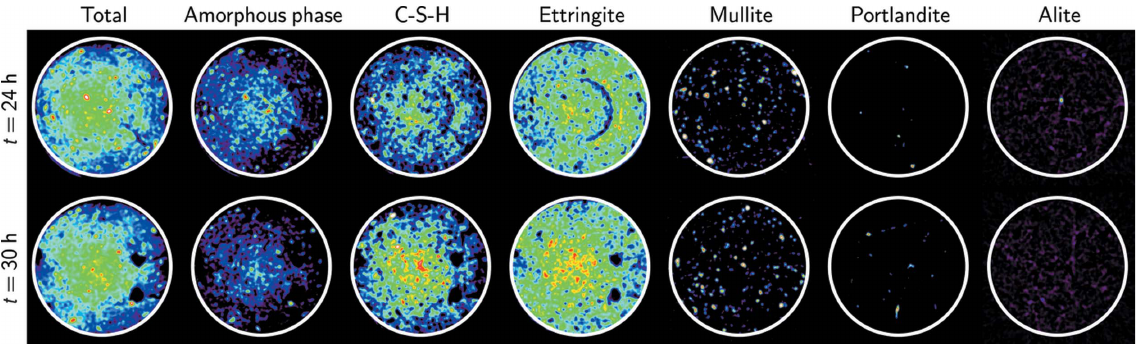
Figure 6 Distribution of the phases after (top row) 24 h and (bottom row) 30 h of cement hydration. From left to right, the distribution maps integrate the contribution of all the identified phases and the amorphous, C-S-H, ettringite, mullite, portlandite and alite phases. Red values indicate a higher content of the phase in the distribution map. Black values indicate voids (Total map) and voids or absence of phase (all other maps). Because all the maps were constructed from the number of counts integrated according to the procedure described in the Materials and methods section, they were scaled individually, and the sum of the colours of each map for the individual phases does not equal the colour of the total intensity map. The white circle of 1.3 mm diameter corresponds to the limit of the